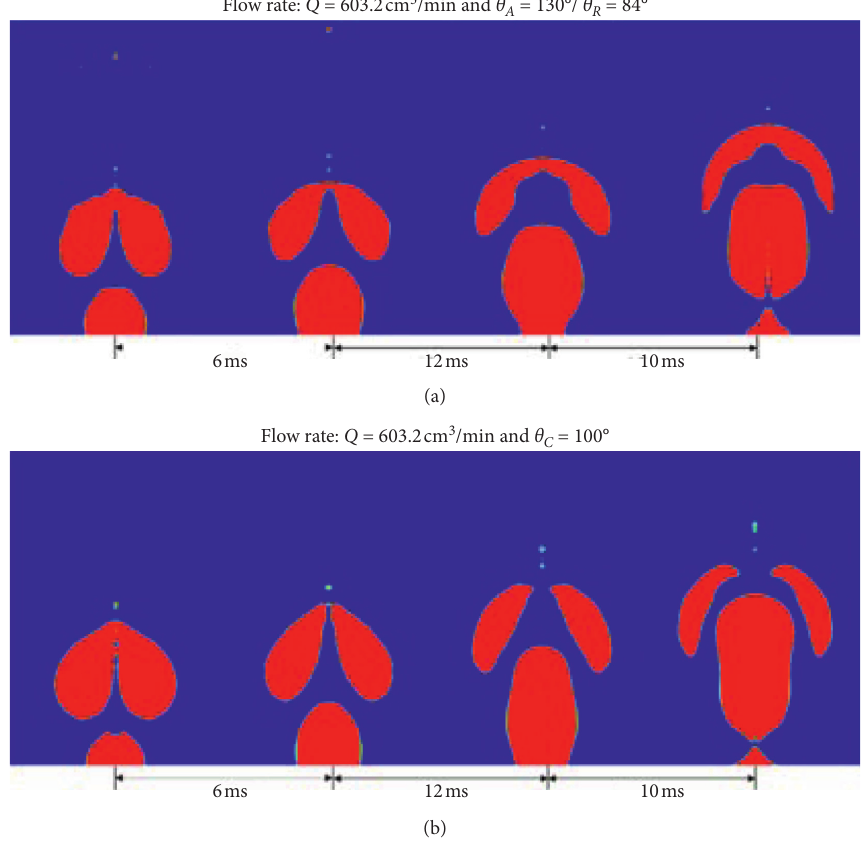
Figure 13: Comparison of flow field between dynamic and static contact angle ( Q � 603.2cm 3 /min, Re � 219.07, and d field by using the dynamic contact angle model; (b) flow field by using the static contact angle model. Snapshots 1–3: formation of the first bubble; snapshots 3–5: formation of the second bubble.